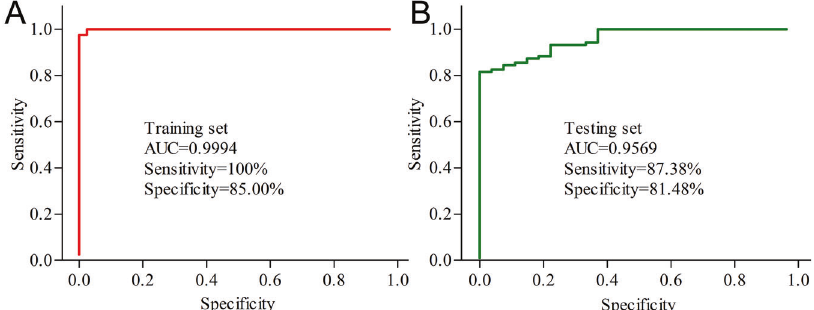
Fig. 4 Diagnostic performance of the obtained discriminative model. A , B A discriminative model consisting of MANF, EWSR1, and ANXA6 discriminated MDD subjects from healthy controls with an area under the receiver operating characteristic curve (AUC) of 0.9994 in the training set ( A ) and 0.9569 in the testing set ( B ).